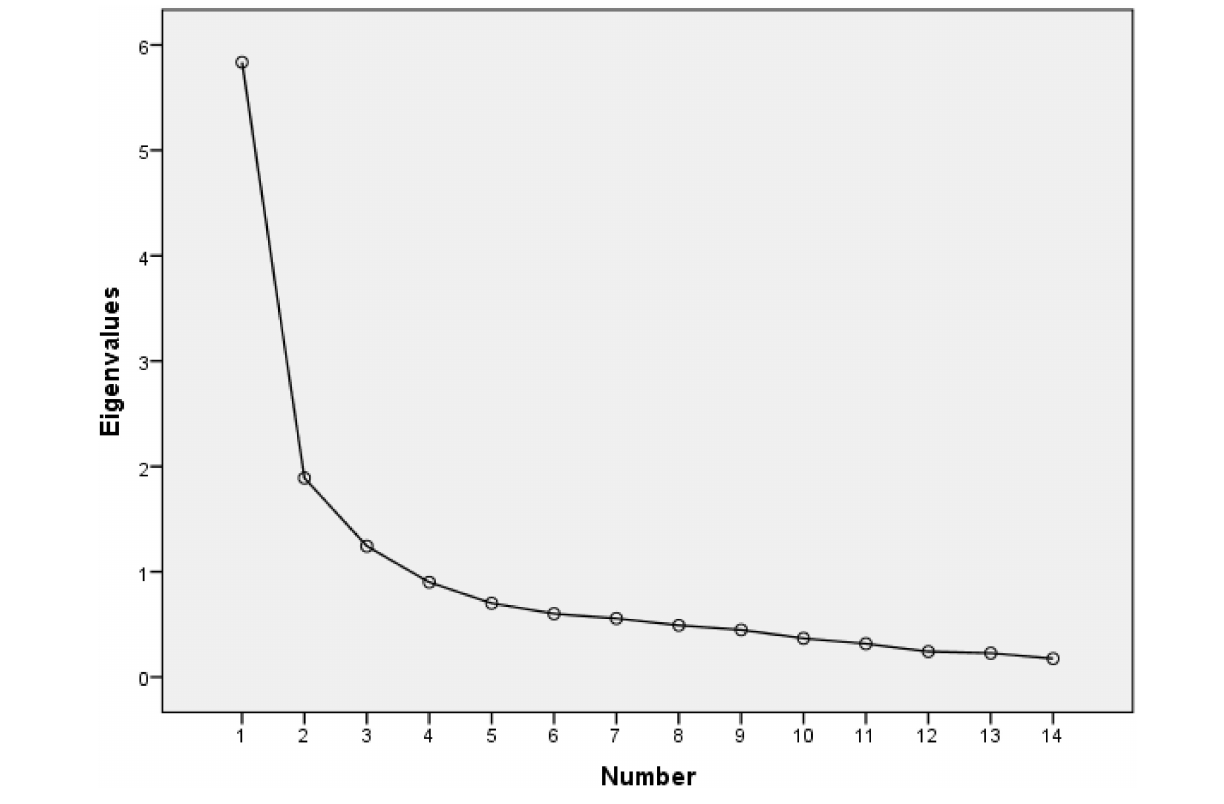
FIGURE 1 | Sedimentation chart of the Spanish version of the ABS Corrigan.